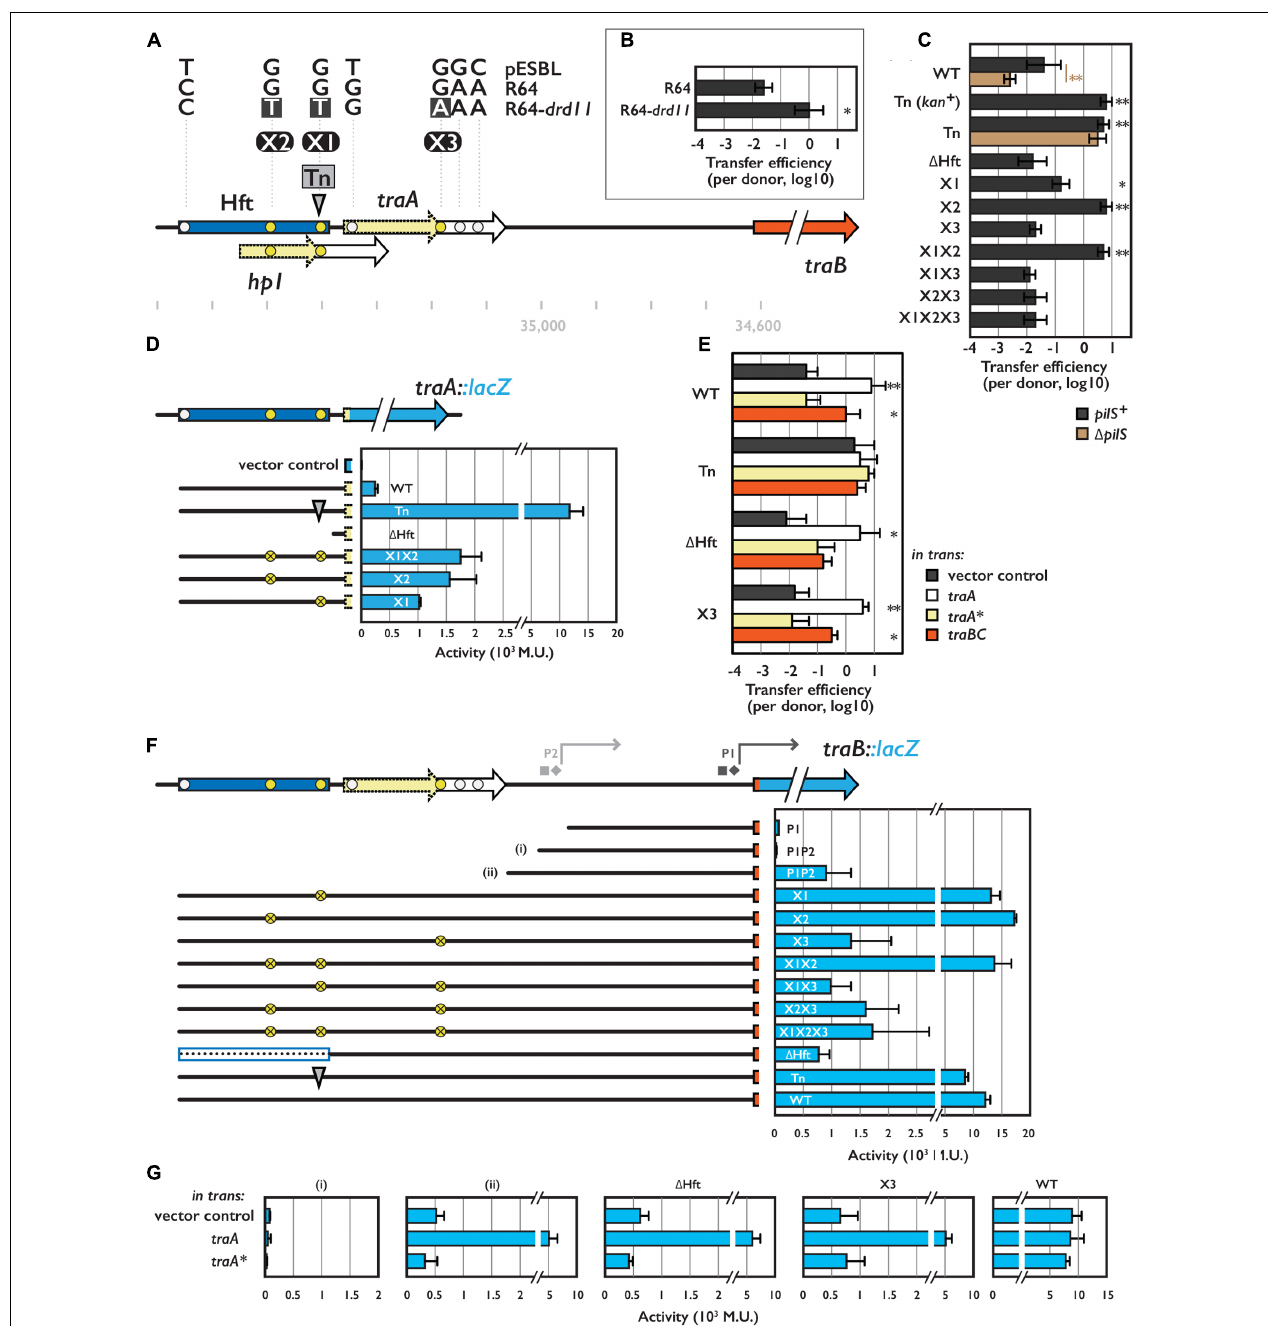
FIGURE 1 | Hft and its flanking region involved in transcriptional regulation for conjugative transfer. (A) Schematic representation of the Hft (shown in blue box) and flanking tra genes. Arrows with solid and broken line indicate coding sequences and its truncated variants, respectively. Transposon insertion site for the Tn mutant is shown by the gray arrowhead. Single nucleotide polymorphisms among pESBL, R64 and R64- drd11 are also indicated (see text). Coordinates shown below are obtained from NC_018659.1. (B) Transfer efficiencies of R64 and R64- drd11 . From (B) through (G) , the mean and standard deviations of at least three independent experiments are shown. (C,E) Transfer efficiencies of various pESBL variants. In (E) , donor cells harbor an extra plasmid for overexpression of indicated gene. (D,F,G) Reporter assay for TraA (D) and TraB (F,G) with indicated construct. β -galactosidase activities were shown in Miller Unit (M.U.). In (G) , cells harbor an extra plasmid for overexpression of indicated gene. In (F) , square and diamond indicate predicted –35 and –10 sequence, respectively. ∗ Indicates p < 0.05 and ∗∗ indicates p < 0.01, respectively.